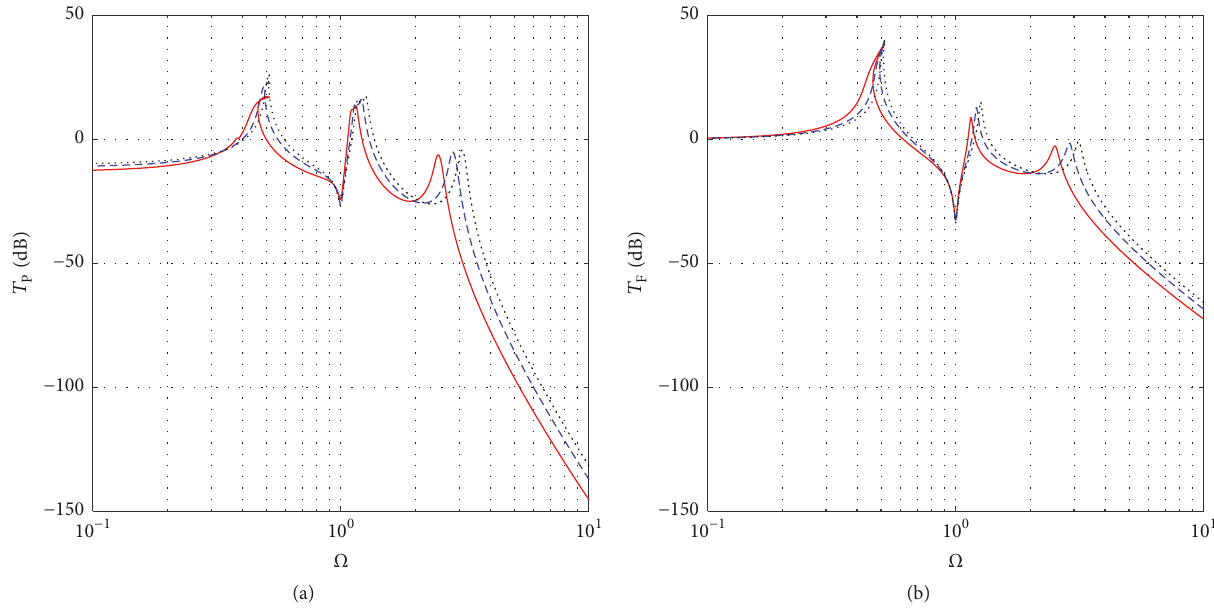
̂𝑙 . The parameters